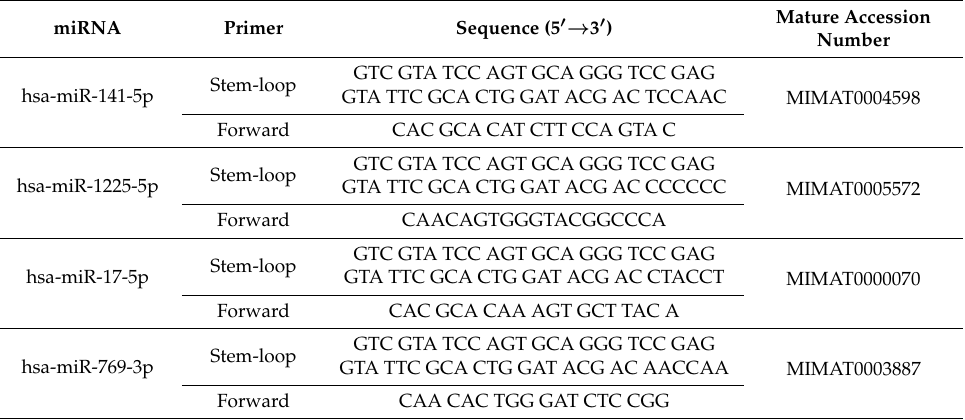
Table 3. List of primers for miRNA